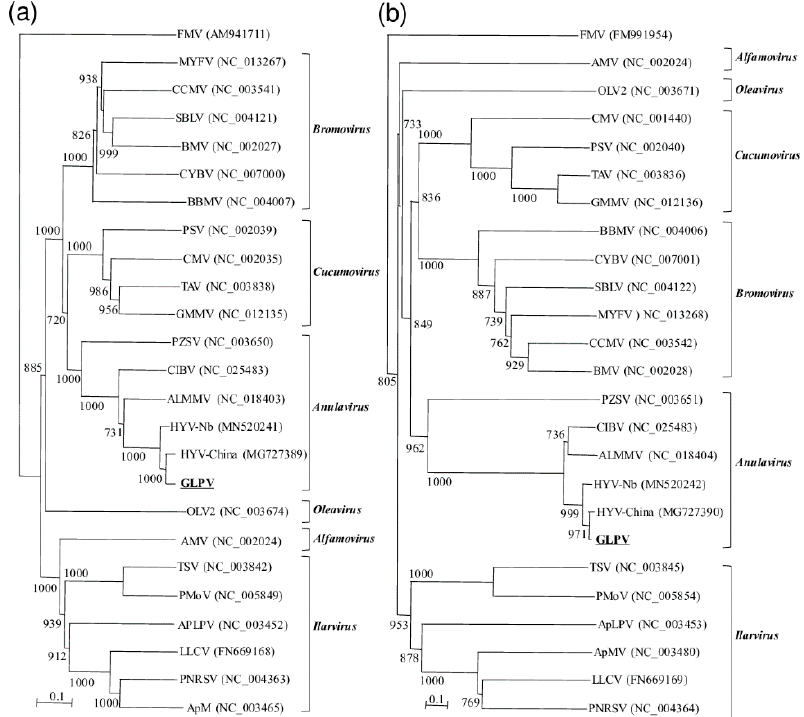
Figure 3. Phylogenetic trees, generated by the “Neighbour-joining” method, constructed based on aa sequences of the ( a ) RdRP and the ( b ) CP of GLPV and members of six genera belonging to the family Bromoviridae: Alfamovirus [alfa mosaic virus, (AMV)], Anulavirus [Amazon Lily mild mottle virus (ALMMV), pelargonium zonate sport virus (PZSV), and the two putative members: hop yellow virus (HYV, isolates China and Nb) and cassava Ivorian bacilliform virus (CIBV)], Bromovirus [broad bean mottle virus (BBMV), brome mosaic virus (BMV), cassia yellow blotch virus (CYBV), cowpea chlorotic mottle virus (CCMV), melandrium yellow fleck virus (MYFV), spring beauty latent virus (SBLV)], Cucumovirus [cucumber mosaic virus (CMV), Ggyfeather mild mottle virus (GMMV), peanut stunt virus (PSV), tomato aspermy virus (TAV)], Ilarvirus [apple mosaic virus (ApMV), prunus necrotic ring spot virus (PNRSV), lilac leaf chlorosis virus (LLCV), apple line pattern virus (ApLPV), pepper mottle virus (PMoV), tobacco streak virus (TSV)] and Oleavirus [olive latent virus 2 (OLV2)]. Fig mosaic emaravirus (FMV) was used to root the trees. Accessions numbers of viruses used are reported within brackets. Numbers on branches indicate percentage of support out of 1000 bootstrap replications. Bootstrap values above 70% are shown. Scale bar represents 0.1 aa substitutions per site.